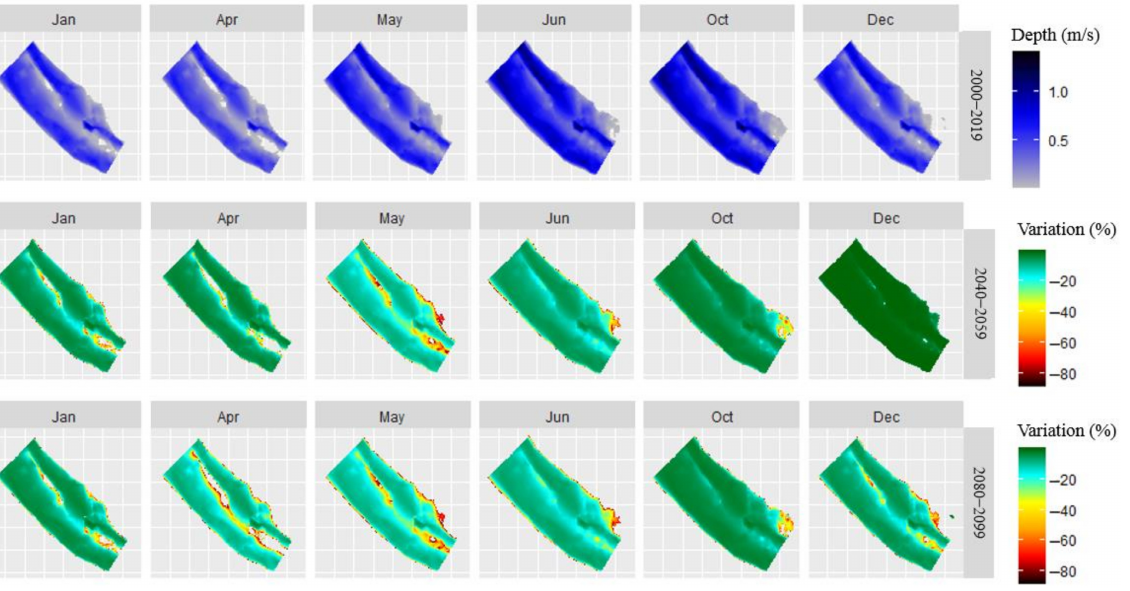
Figure 11. Variation in the monthly average depth of flow for the CCS, concerning the period